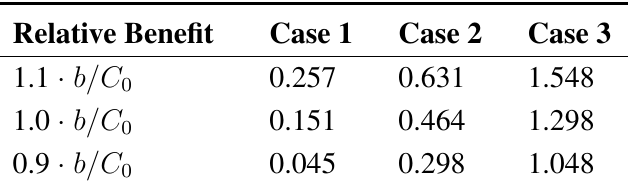
Table 10. Profitability W for different development stages (cases) and different relative benefit values. b : benefit; C : total investment 0